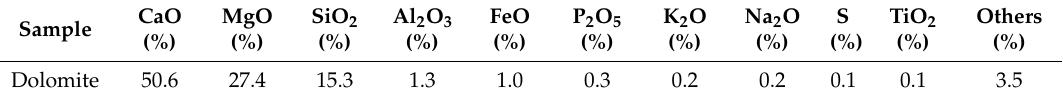
Table 1. Main components as mass fractions (XRF) of the calcined (950 ◦ C) dolomite.